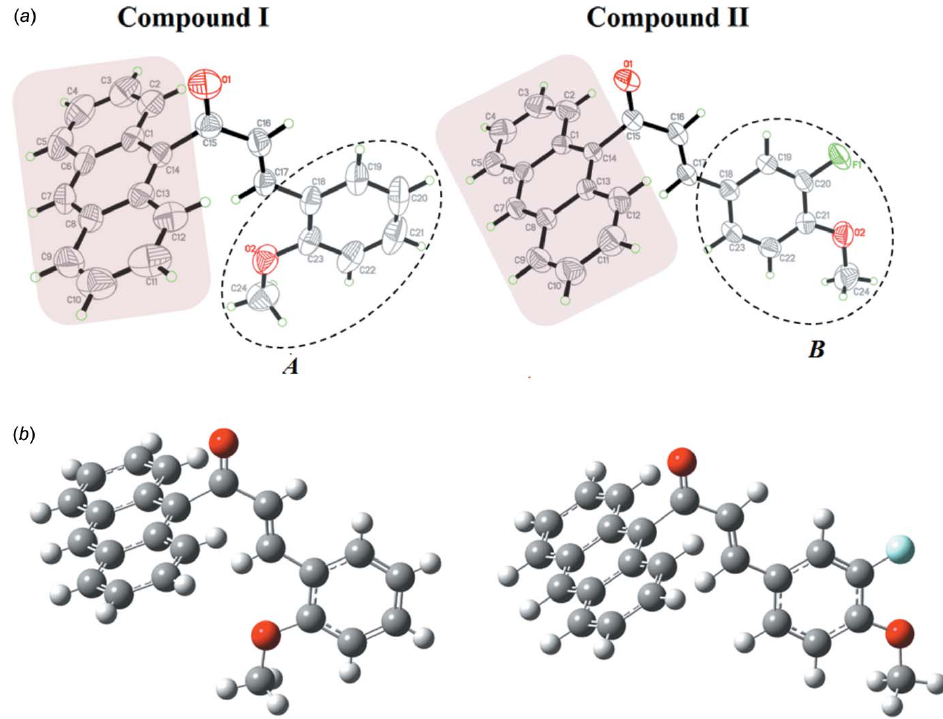
Figure 1 ( a ) The molecular structure for compounds (I) and (II) showing the atom-numbering schemes and 50% probability ellipsoids; ( b ) The DFT-optimized structures at the B3LYP 6–311++G(d,p) level for compounds (I) and